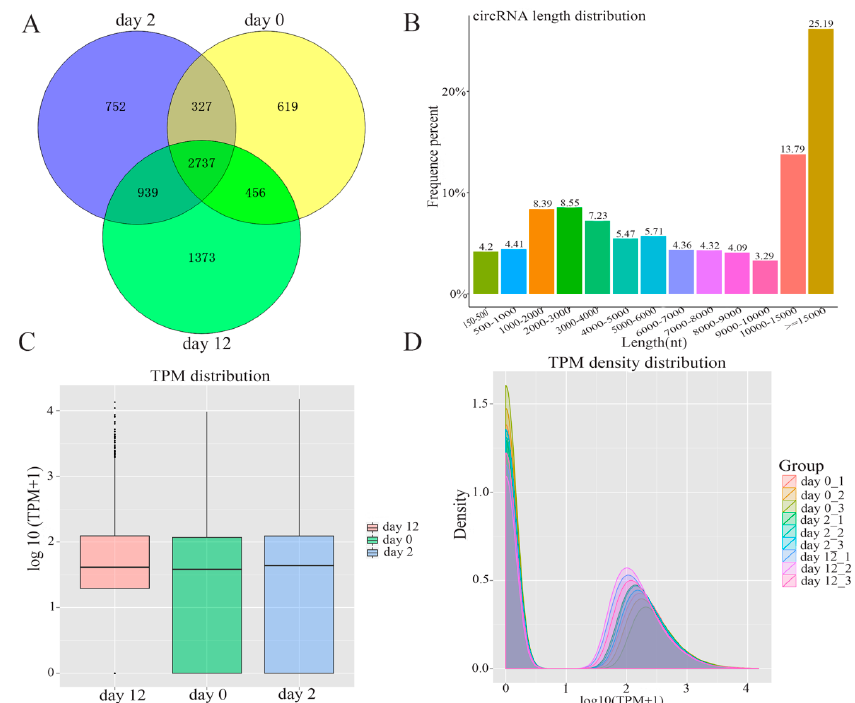
Figure 2. The expression pattern of circRNAs detected by high-throughput RNA sequencing during yak adipocyte differentiation. ( A ) Venn analysis of circRNAs detected at each time point. ( B ) The full-length distribution of circRNAs. ( C ) Box plots of transcripts per million clean tags (TPM) value for circRNAs in three groups. ( D ) The density distribution of circRNAs in pre-adipocytes and adipocytes.